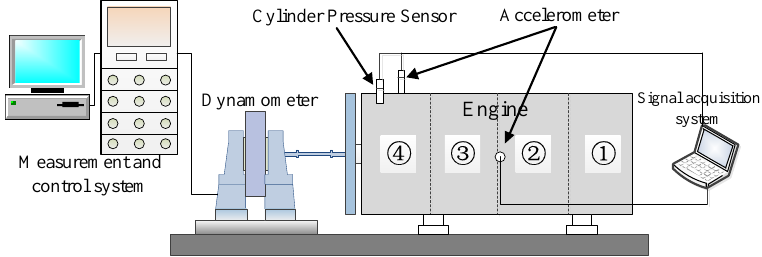
Figure 1. Schematic diagram of the setup used in the experiments.